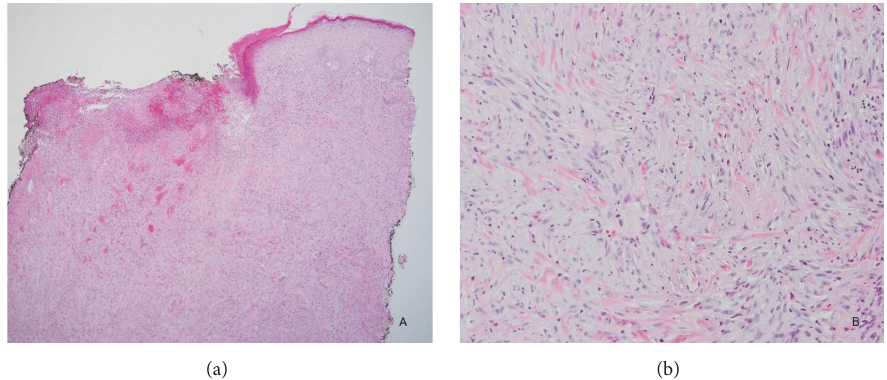
Figure 1: (a) Punch biopsy reveals a spindle cell lesion infiltrating the dermis (H&E, 40x); (b) (H&E, 200x).